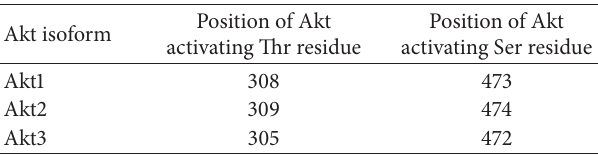
Table 1: Coordinates of the Akt activating threonine (Thr) and serine (Ser) residues among the three Akt